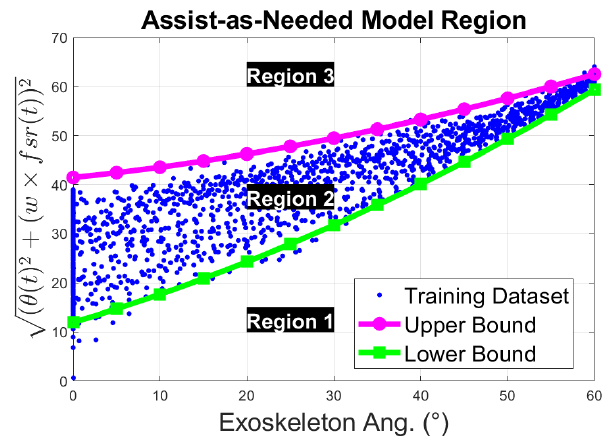
Figure 12. Assist-as-Needed trained model regions to infer subject’s action.